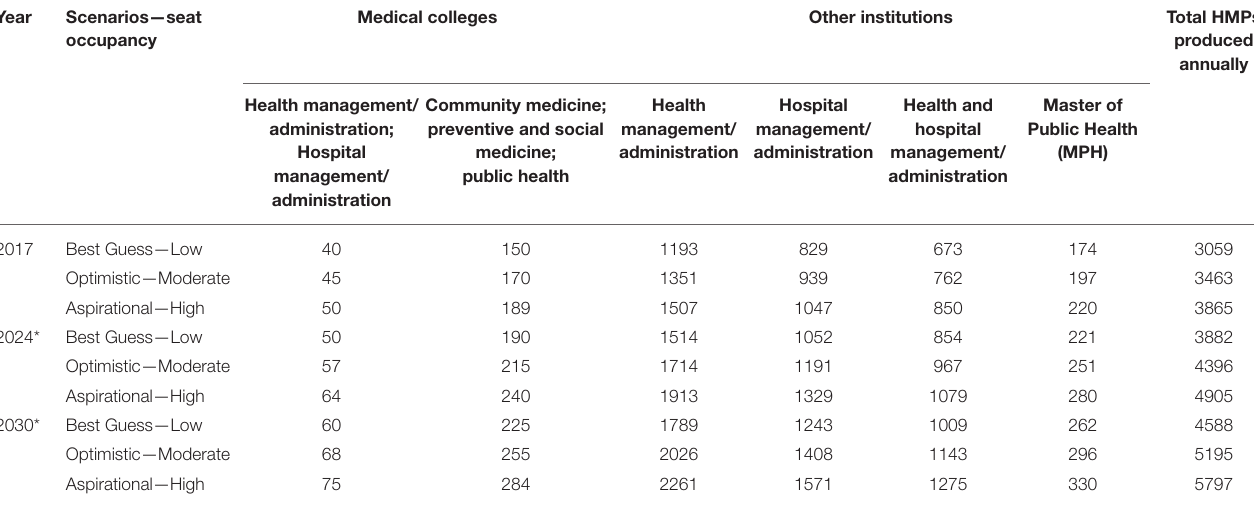
TABLE 2 | HMPs produced annually in best guess, optimistic and aspirational scenarios in